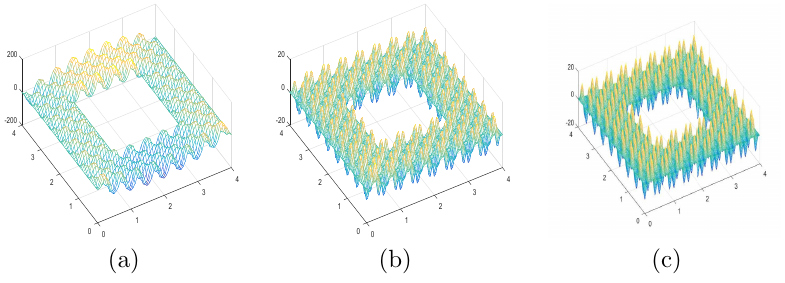
Figure 4. Numerical solution u 2 for (a) h = 1 / 16; (b) h = 1 / 32; (c) h = 1 / 64.